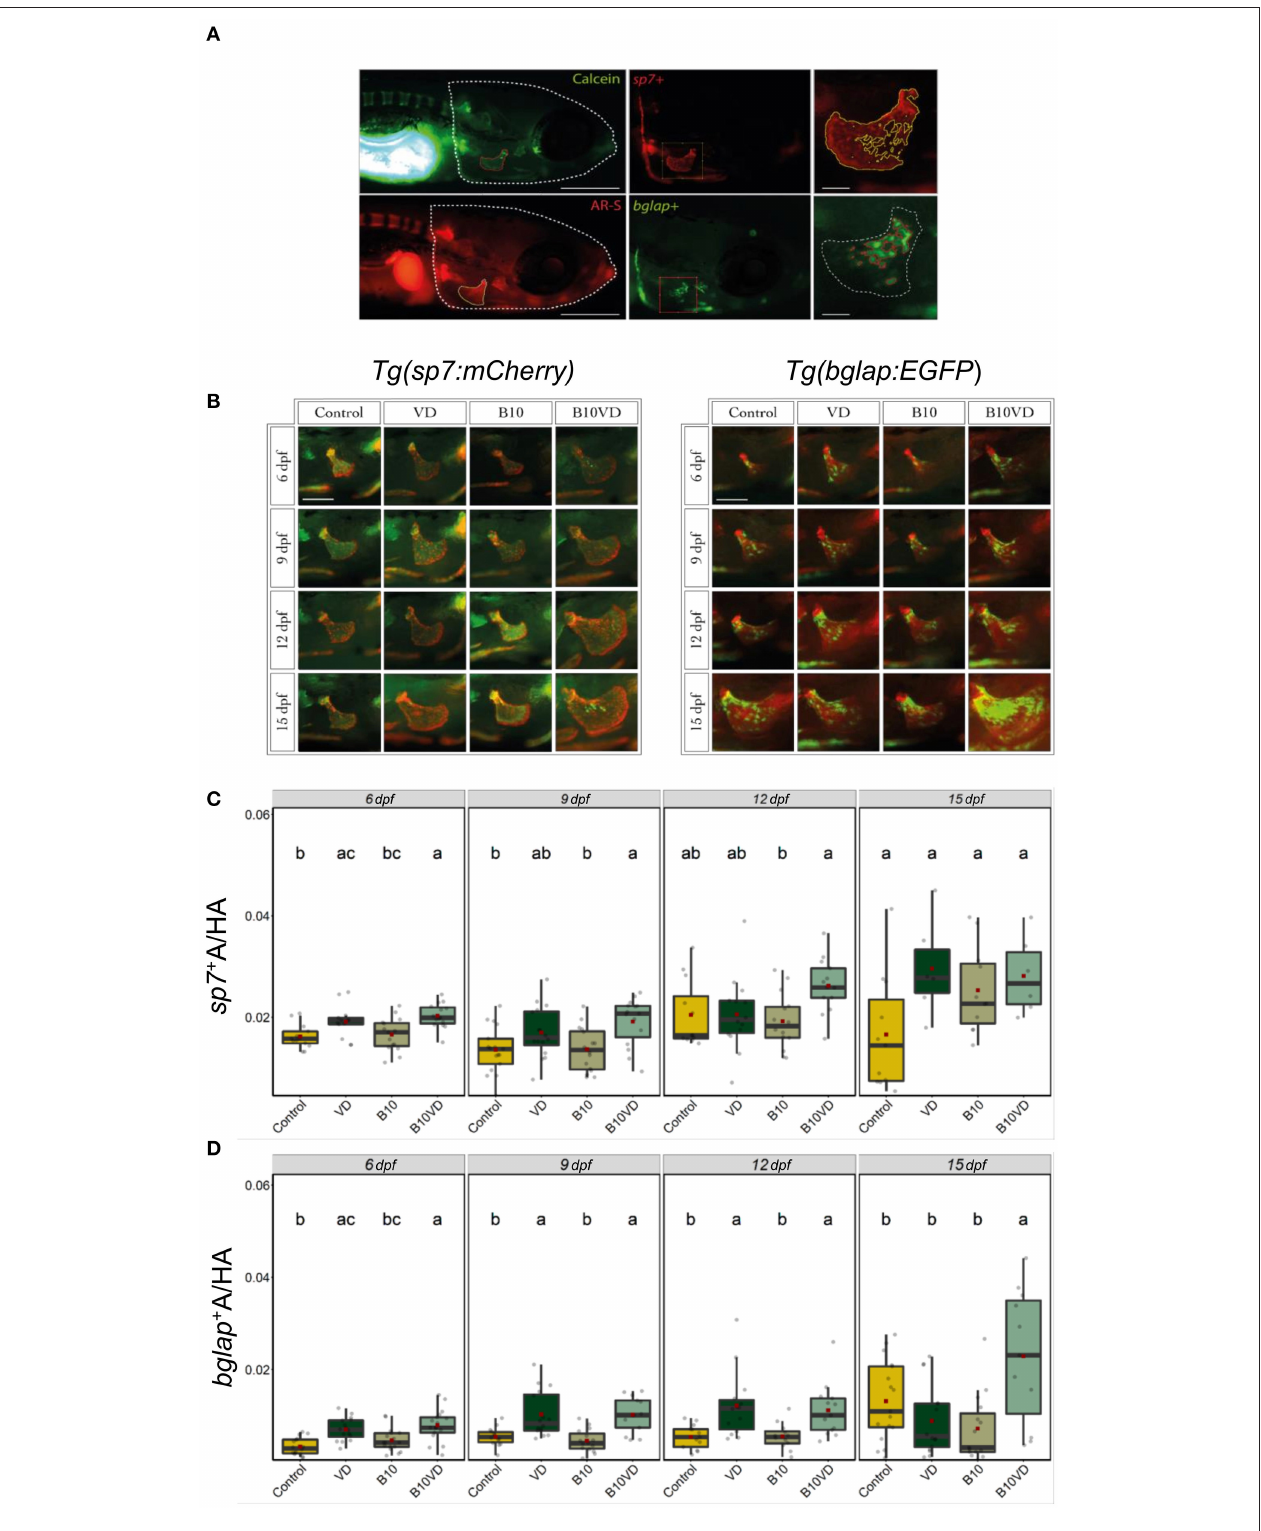
FIGURE 6 | Early and mature osteoblasts respectively tracked by the fluorescence expression of Tg(sp7:mCherry) and Tg(bglap:EGFP) . Four groups of treatment are ethanol at 0.1% (Control), VD group with VD3 at 10 pg/ml (VD), B at 10ng/ml (B10), B at 10ng/ml with VD3 at 10 pg/ml (B10VD). (A) An example of how the areas of the operculum and sp7 + and bglap + were measured (big scale bar = 0.35mm; small bar = 0.05mm). (B) A table with merged pictures of operculum from the